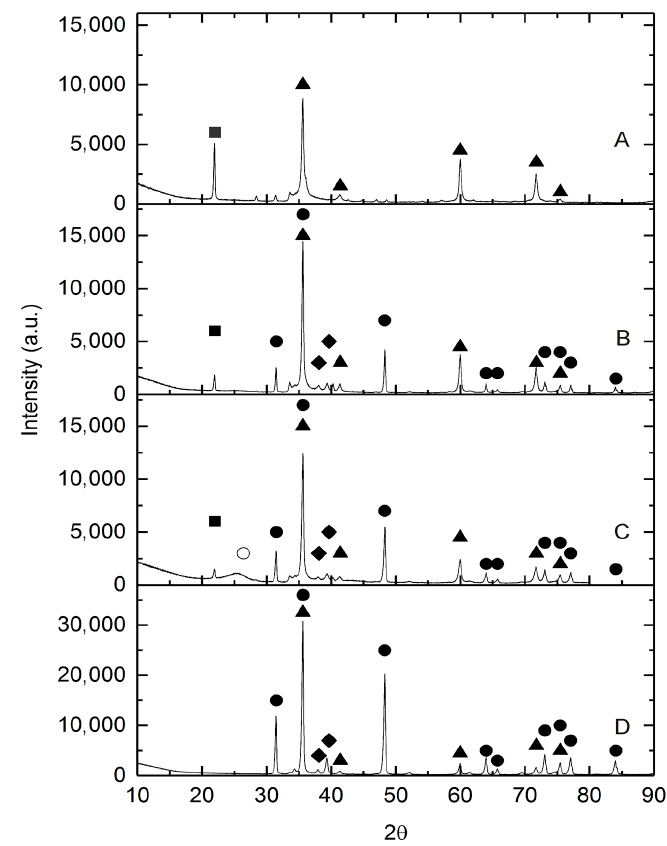
Figure 1. The XRD patterns of nanocomposite samples: ( A ) β -SiC; ( B ) (5) W x C- β -SiC; ( C ) (10) W x C- β -SiC and ( D ) (20) W x C- β -SiC. Crystalline phases: — β -SiC, —WC, —W 2 C, cristobalite, ○